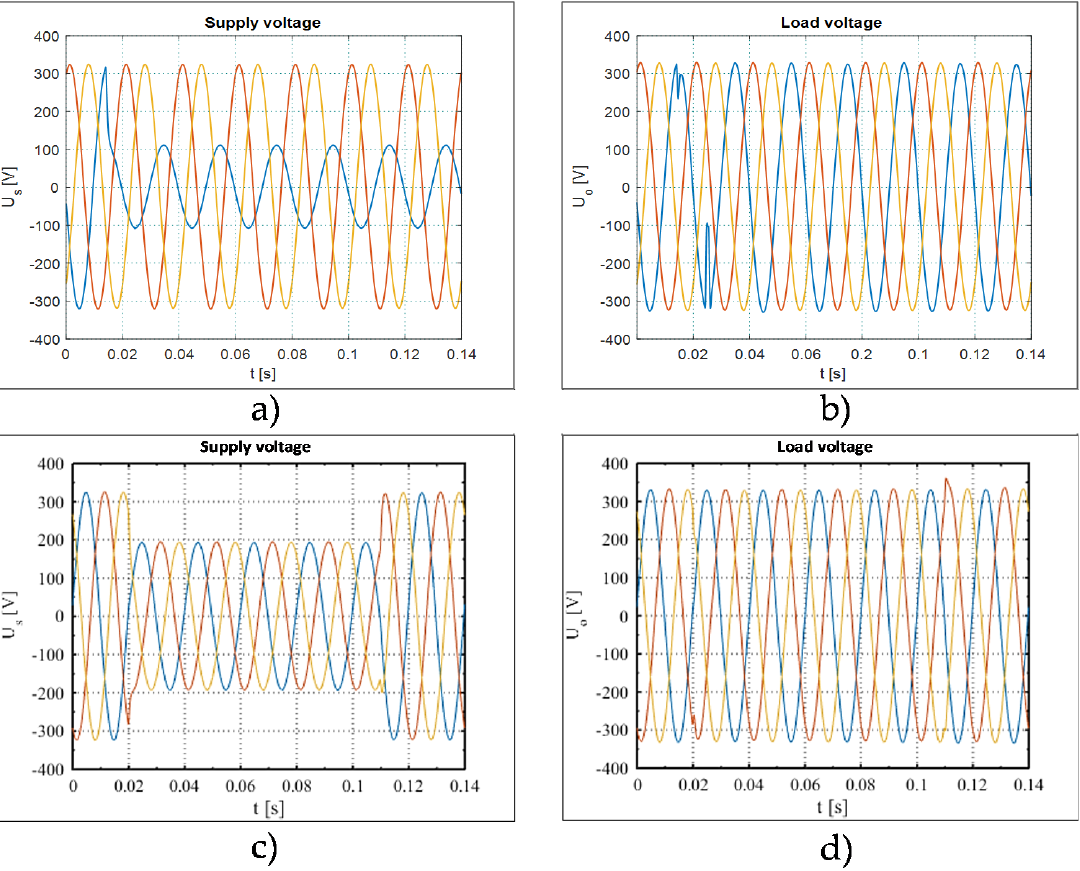
Figure 7. Voltage registrations—the graphs on the left show the voltage from the mains, graphs on the right show the voltage from the robot’s power supply. ( a ) one-fhase voltage dip; ( b ) voltage waveform at the supply robot behind DVR after one-phase voltage dip; ( c ) three-fhase voltage dip; ( d ) voltage waveform at the supply robot behind DVR after three-phase voltage dip .